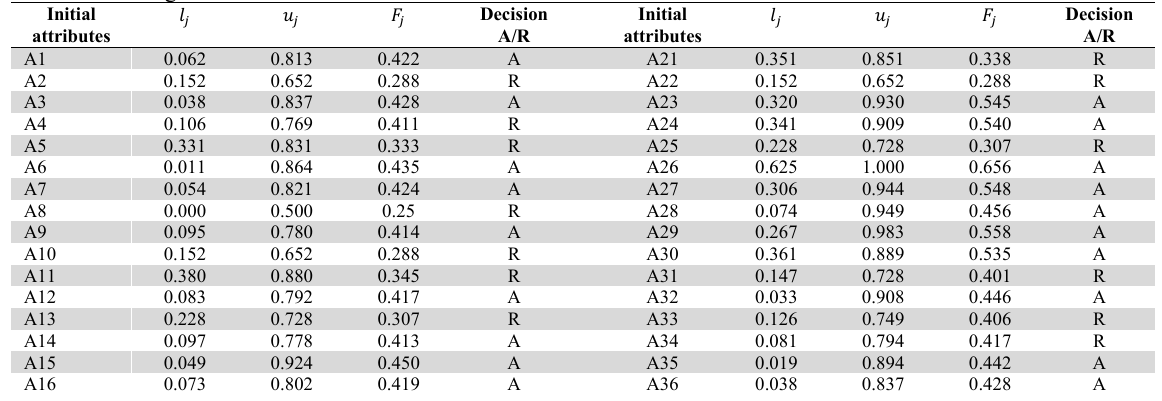
Factors screening out after FDM round 2 Initial